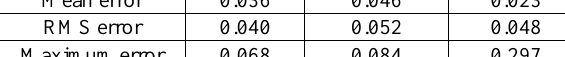
Table 1. Relative accuracy estimation of MLS data using